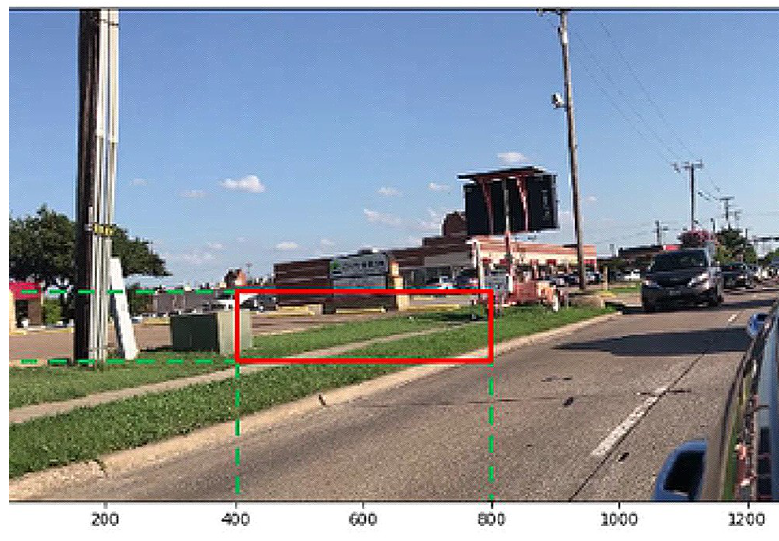
Figure 8. Blind spot setting